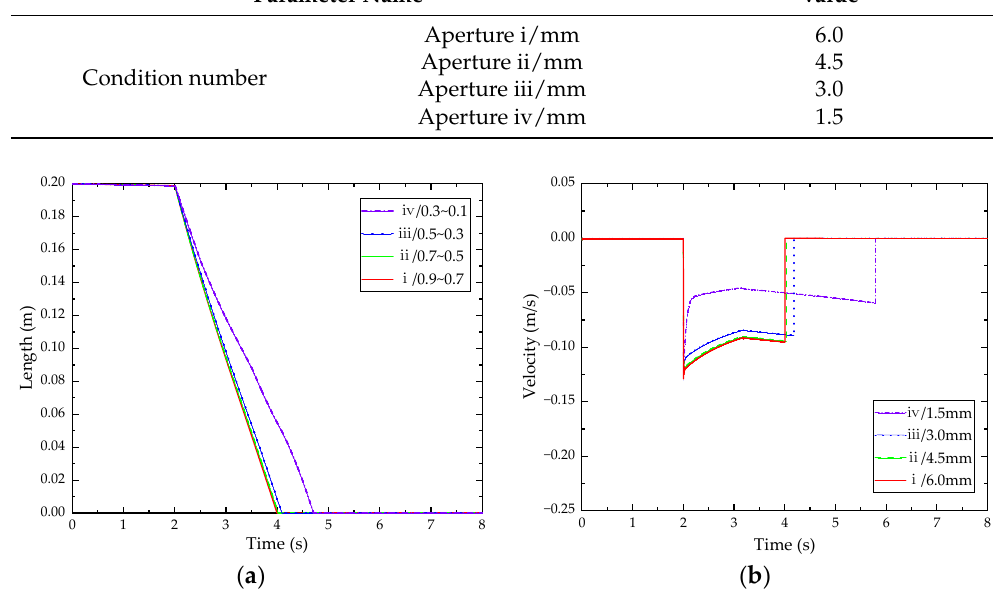
Figure 9. Effect of oil filter blockage: ( a ) Piston displacement; ( b ) Piston Velocity.